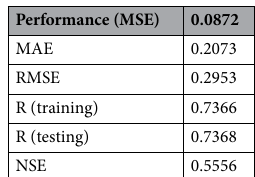
Table 3. Evaluation using SCG